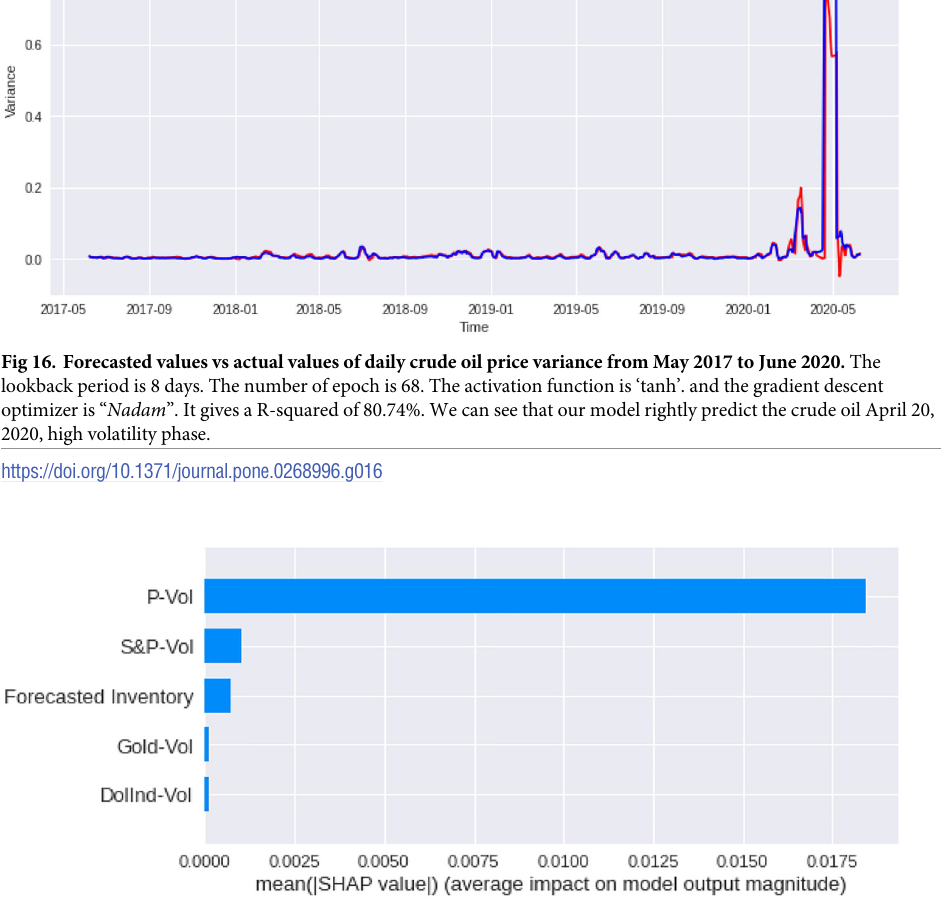
Fig 17. Mean Shapley values for the current day using Adam optimizer.